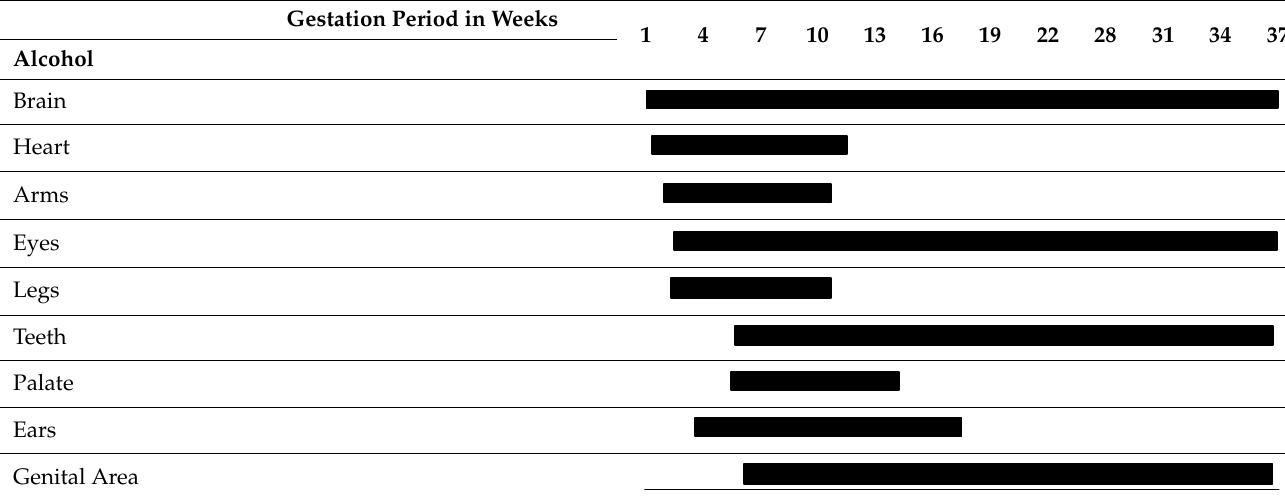
Table 1. Timeline of human fetal organ development.